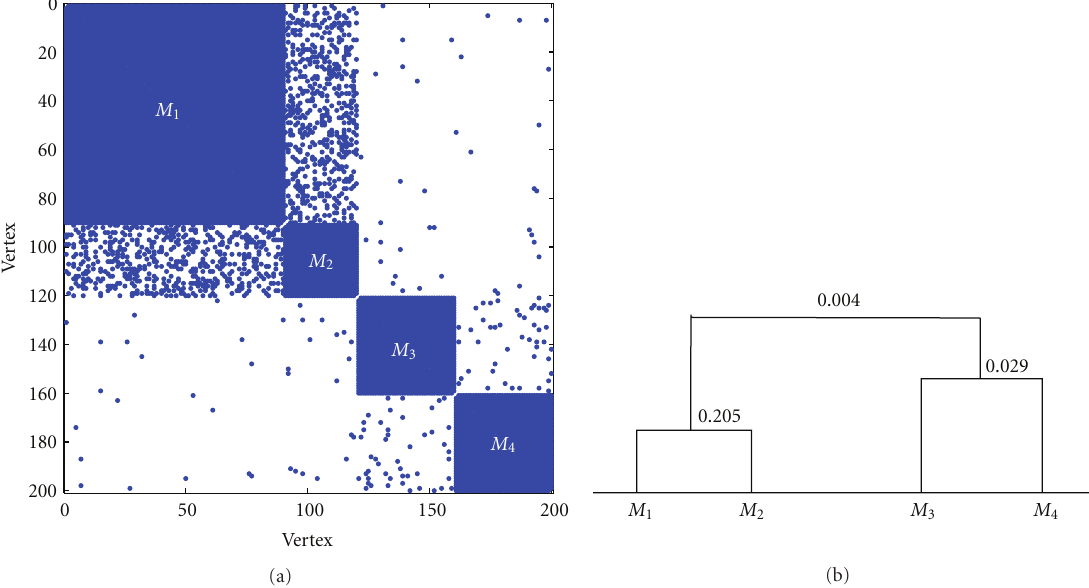
Figure 2: Example of hierarchical modular network structure. (a) Pattern of the adjacency matrix; (b) the hierarchical structure of the network.